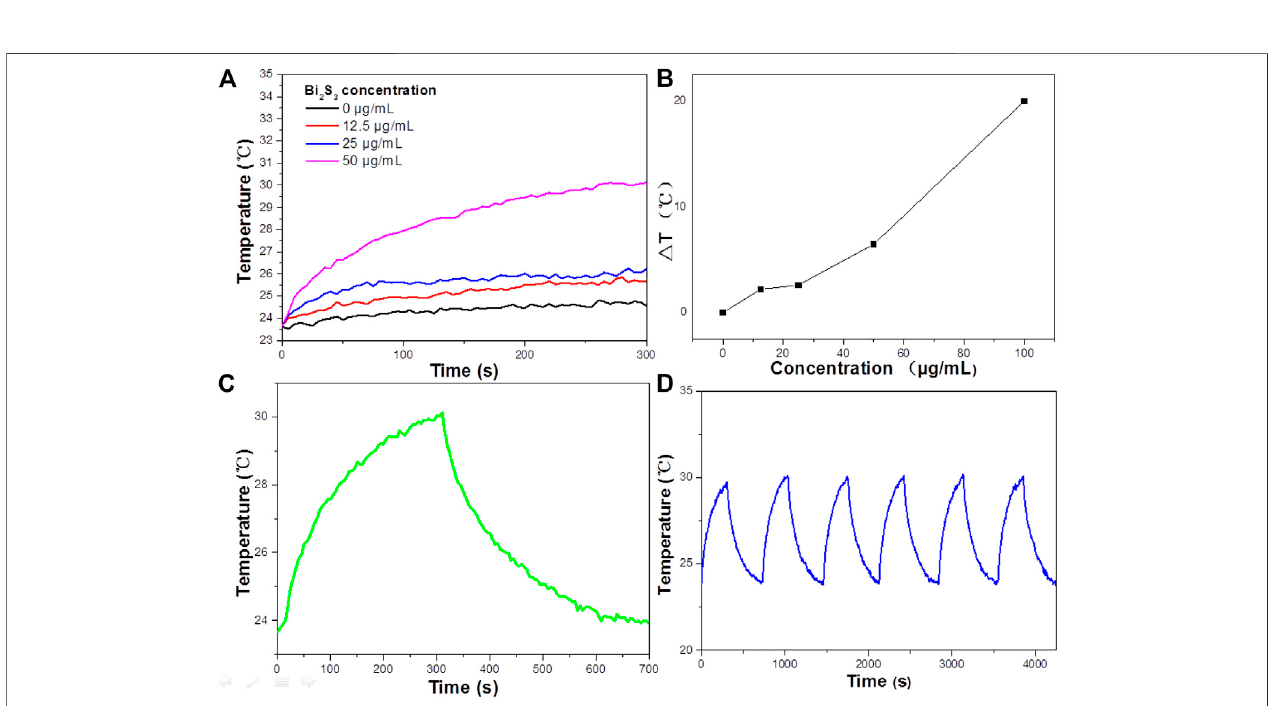
FIGURE 2 | (A) The Absorbance spectra of RB standard solutions of different concentrations. (B) Absorbance-concentration fi tting curve of RB solution. (C) UV — vis absorbance spectrum for the aqueous dispersion ofthe Bi 2 S 3 NPs. (D) The reduced rate of RB on the surface of the Bi 2 S 3 NPs under UV light, visible light, and NIR laser irradiation, all light power density is 1 w/cm 2